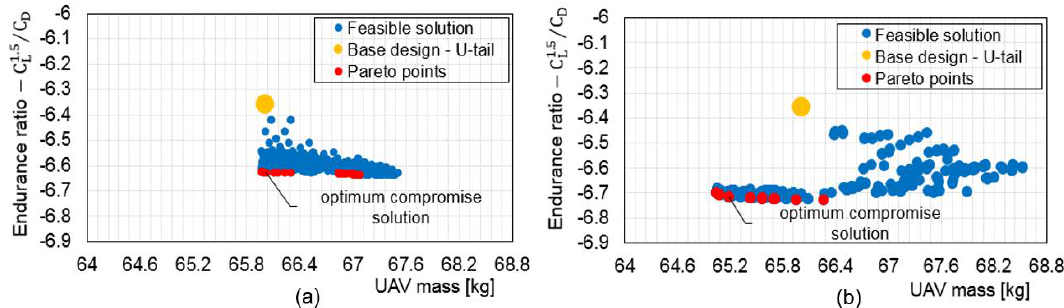
Figure 9. Optimisation results for the Aegis UAV with U-tail. (a): optimisation results using wing design variables with only 2400 evaluations (average run time 39 min). (b): optimisation results using wing and tail components simultaneously using 5500 evaluations (average run time 135 min).